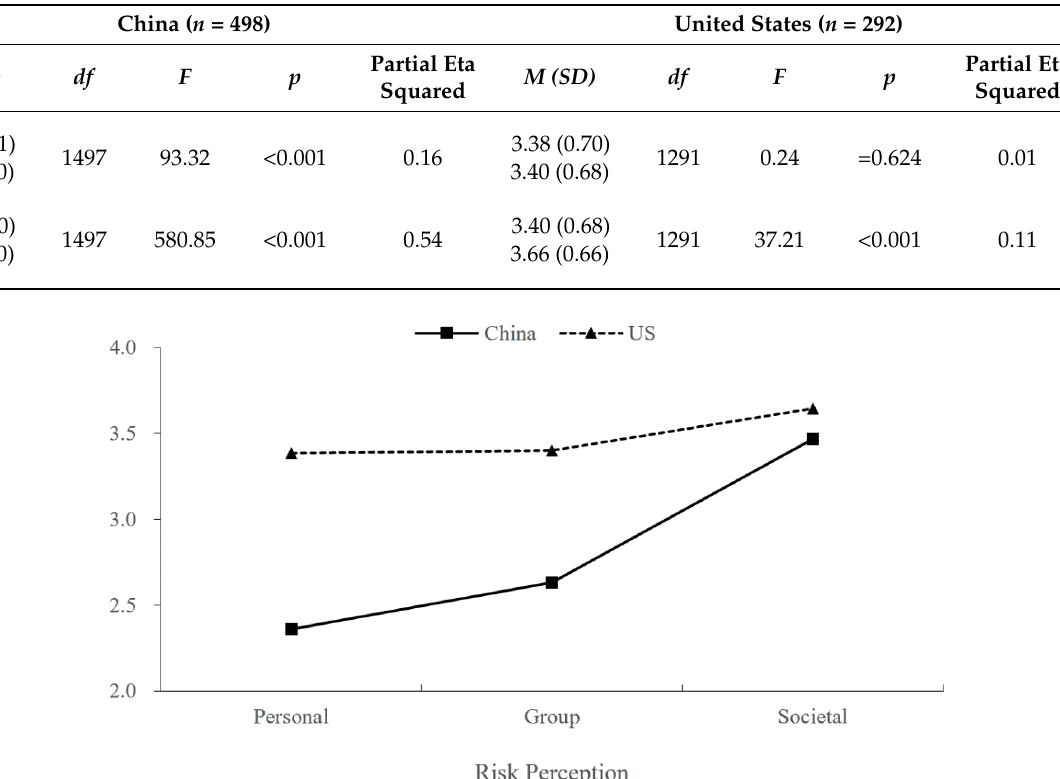
Figure 2. The “ascending pattern” of risk perceptions along the personal-group-societal levels in two countries.